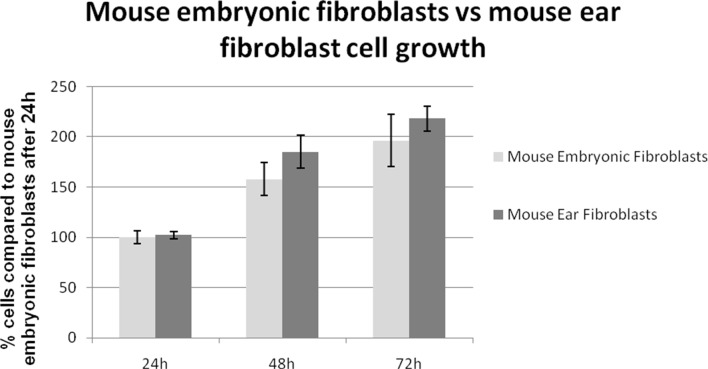
ASF (dark grey) cell numbers are expressed as a percentage of cells relative to the number of MEFs (light grey—100%) counted 24 h after seeding.No significant differences in cell growth were observed after 72 between the two cell types.